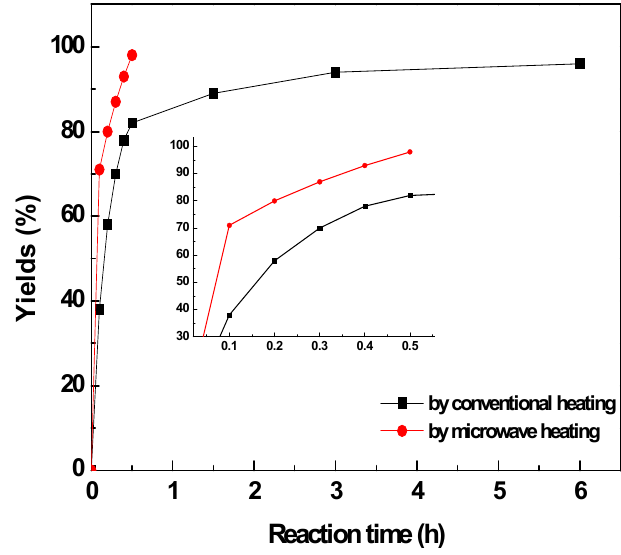
][EtNHC SO ] (1.0 g) and 50 wt % of H 2222 3 3